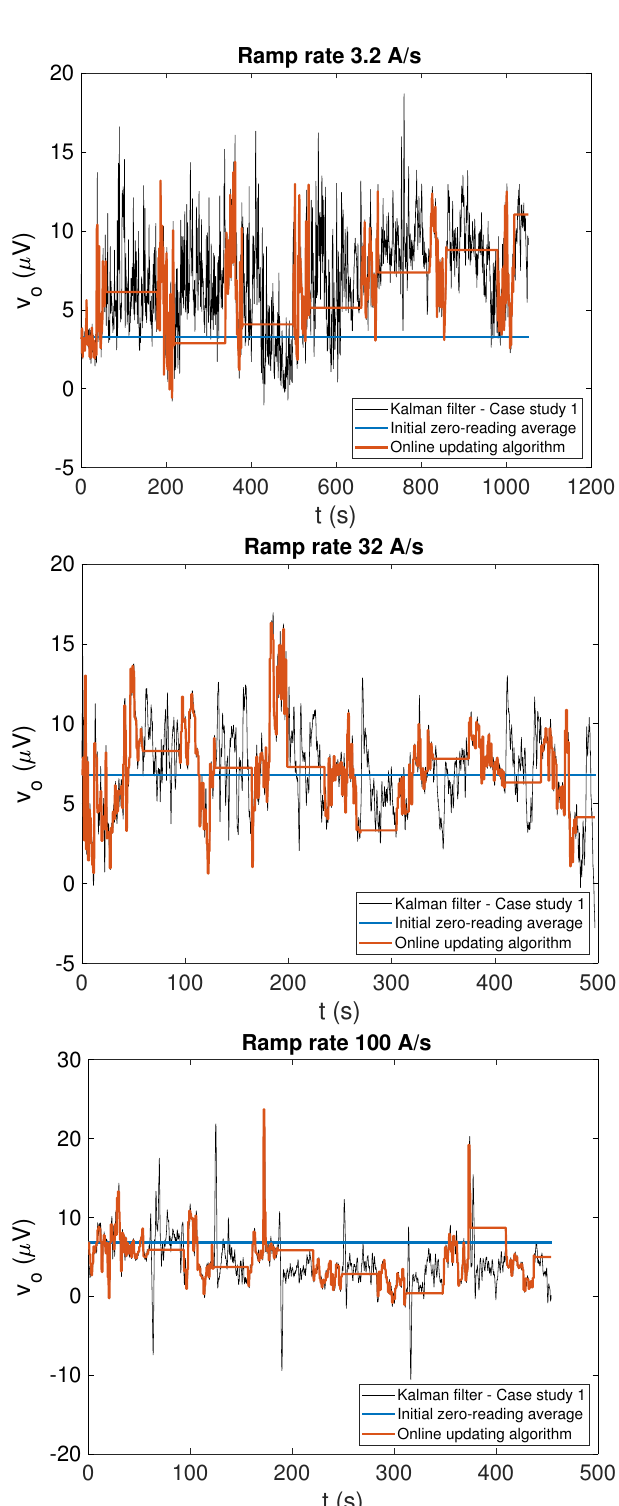
Figure 5. Estimated offset voltage values obtained by Kalman filtering (black), when the field values measured by Hall probe are used in the measurement equation (case study 1) and the two feed-forward offset correction algorithms (FFA1 in blue, FFA2 in orange) plotted for comparison. The corresponding field values obtained by applying the different algorithms can be observed in Figure 7. The flat parts of the FFA2 curve correspond to cycle ramps, where the offset is not